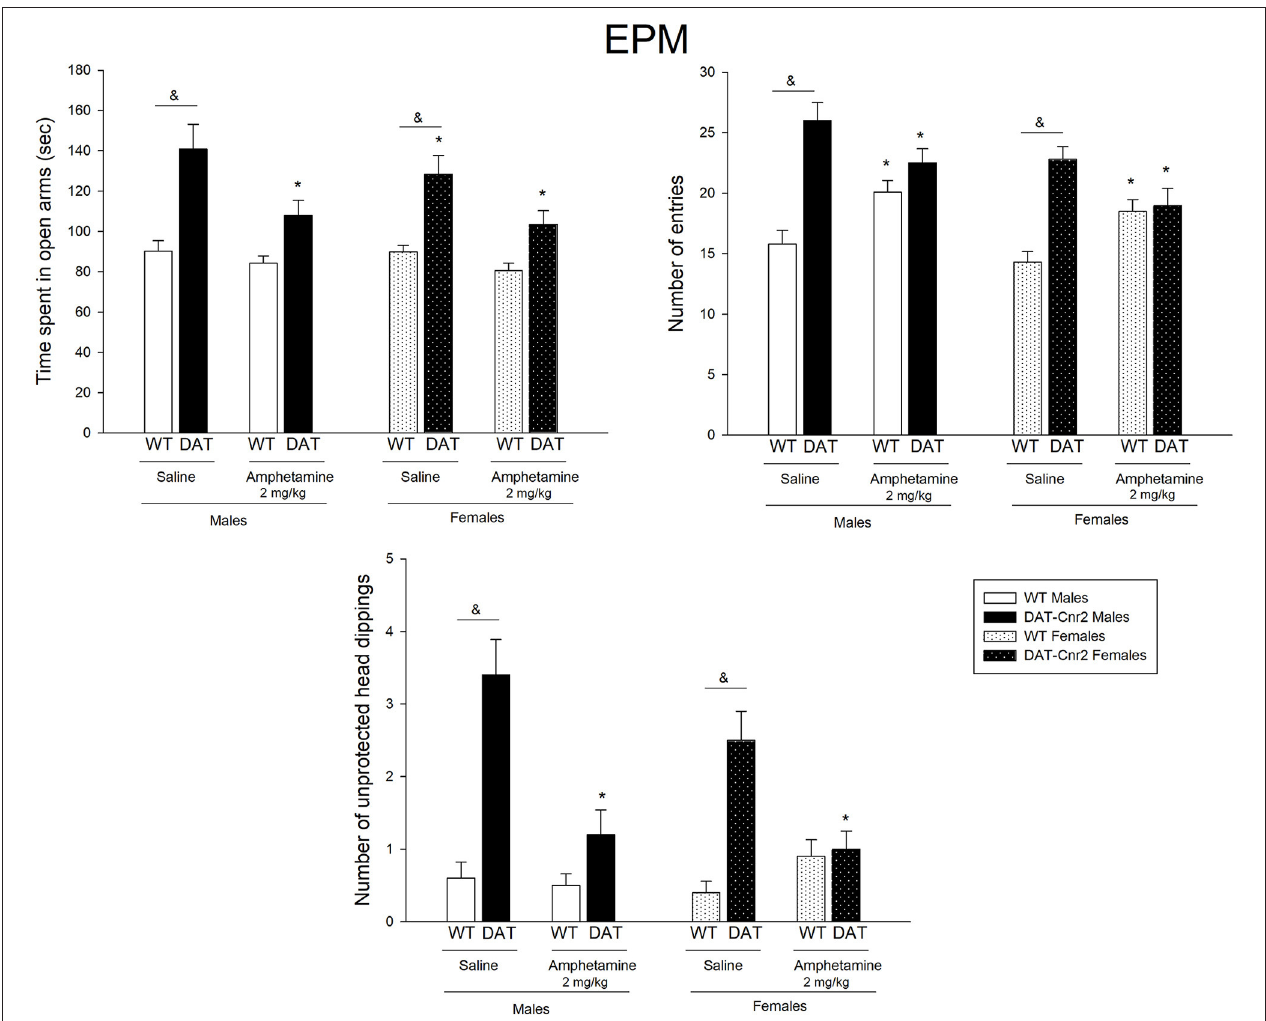
FIGURE 6 | Performance of adolescent DAT- Cnr2 male and female mice in response to a single administration of a low dose of amphetamine on the specific parameters of the EPM. Time spent in the open arms of the maze, expressed in seconds over 5 minutes, number of entries in total as general locomotor activity during the test and number of unprotected head dips (UHD) as a measure of reduced inhibition. Data are depicted mean ± SEM. The white bars represent the WT and the black bars represent DAT- Cnr2 cKO mice. Males depicted in clean bars and females in bars with dots. Data are expressed as mean ± SEM ( n = 10 mice per group). Three-way ANOVA followed by Tukey post hoc test * p < 0.05 for treatment and & p < 0.05 for